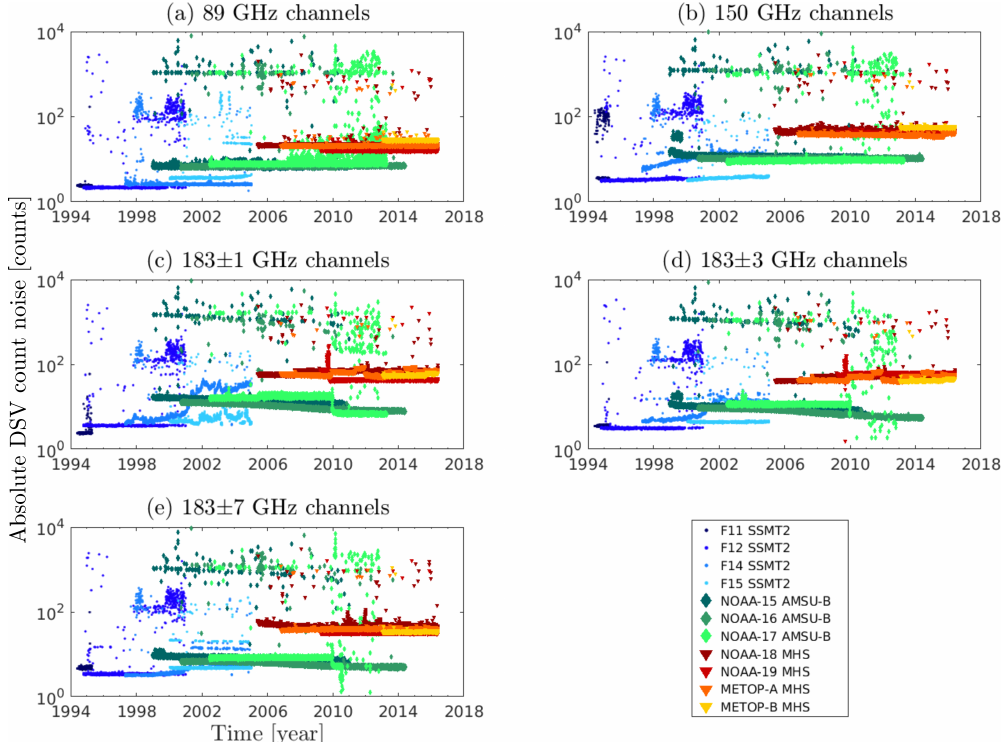
Figure 6. Time evolution of the DSV count noise for the five frequency channels.